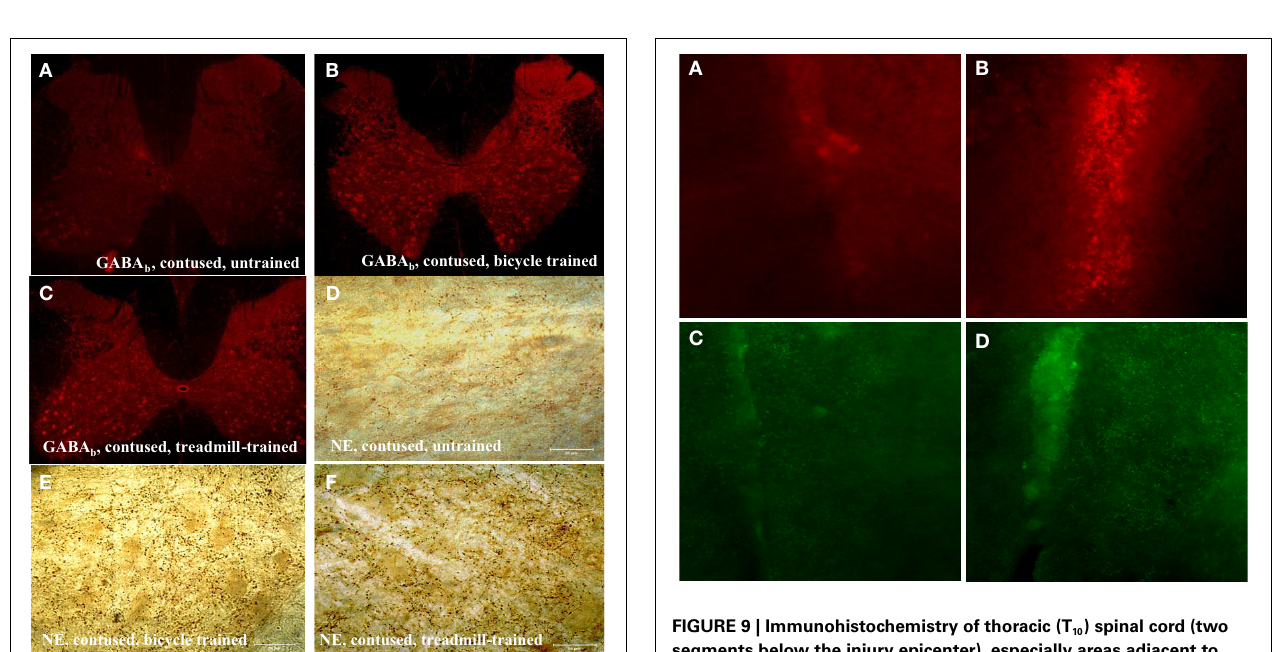
this initial 2 week period following midthoracic contusion SCI.